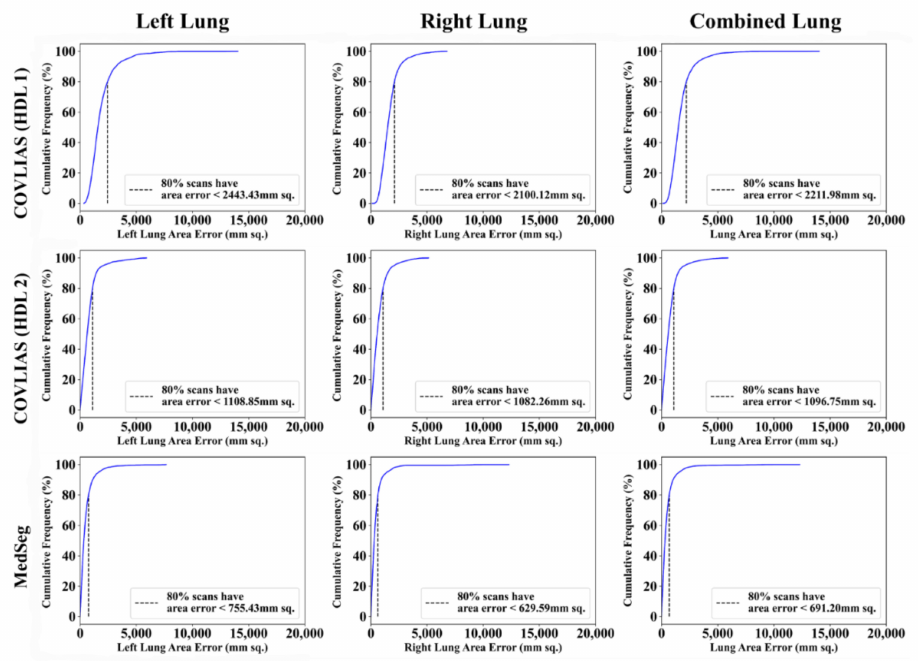
Figure 17. Cumulative frequency plots: COVLIAS (row 1 and row 2) vs. MedSeg (row 3) using MD 2. Column 1: left lung, column 2: right lung, and column 3: mean of left and right lungs. COVLIAS (HDL 1): VGG-SegNet; COVLIAS (HDL 2):